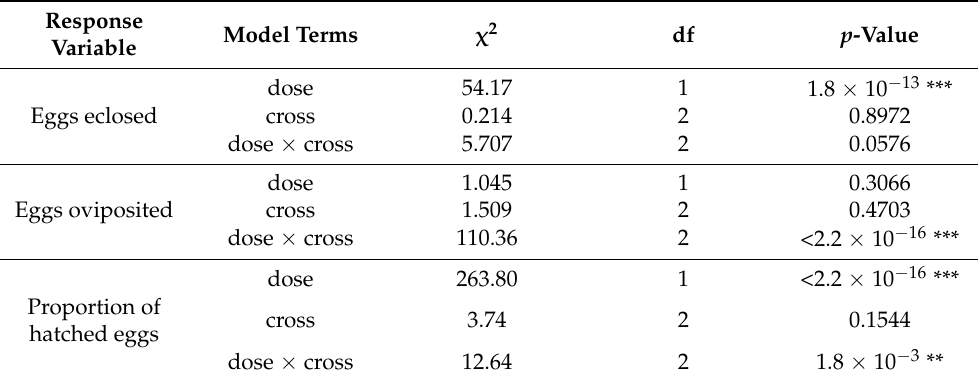
Table 1. Analysis of deviance of the GLiM models. (Type III). The overall effect of dose and cross types on the number of eclosed eggs, the number of oviposited eggs, and the proportion of eggs hatched per female are reported.